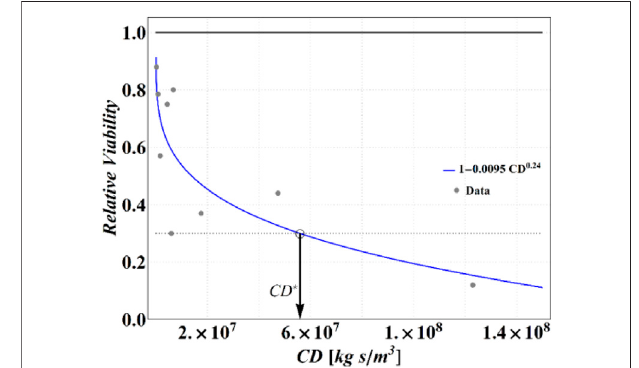
FIGURE 3 | Experimental data from Lin and Marr (Lin and Marr, 2020) and the best fi tting curve. A threshold RV of 0.3 (dotted line) has been assumed to fi nd a critical value of cumulative dose CD